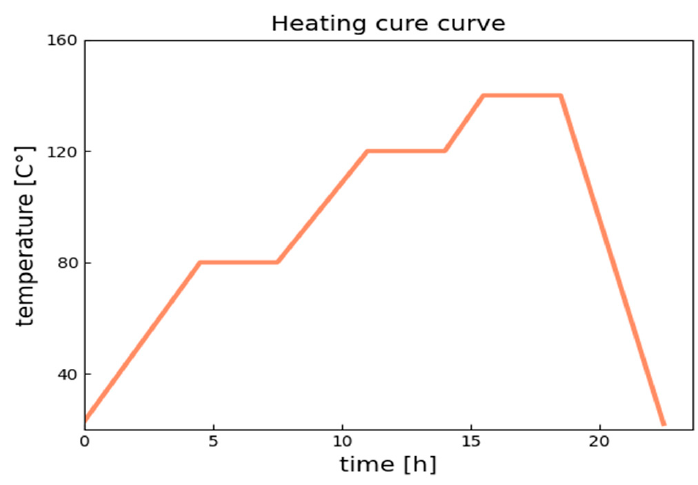
Figure 1. Heating cure curve used for curing resin samples.